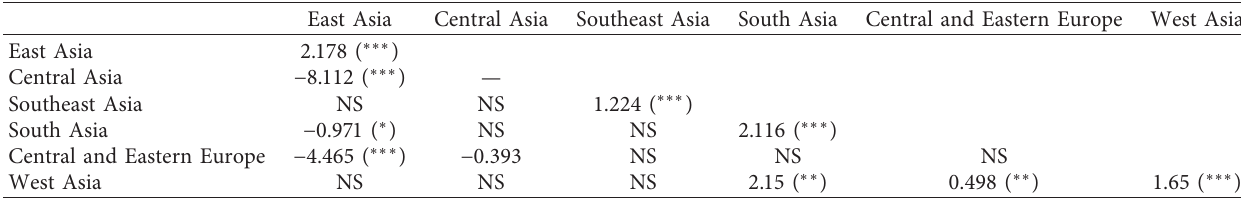
Table 8: Results of OLS regression analysis of the GD within and between